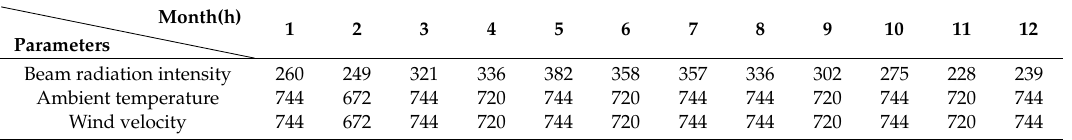
Table A3. Detailed amount of hours for calculating average value per